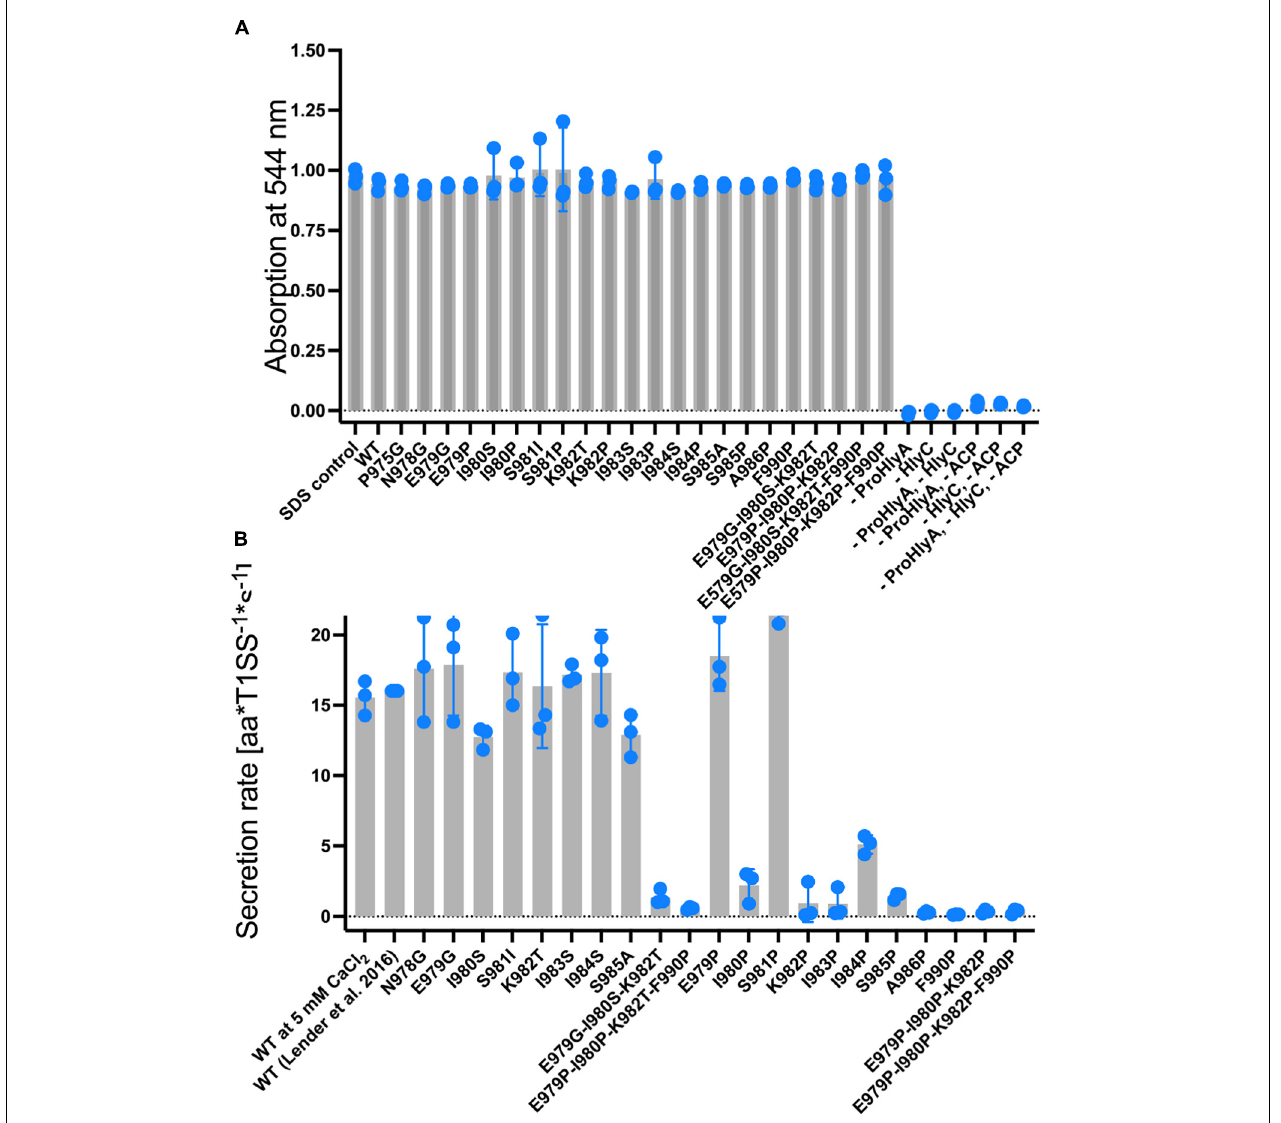
FIGURE 4 | (A) Normalized hemolytic activity of wild type HlyA (left bar), single, triple and quadruple mutations within the secretion signal. The lysis of erythrocytes was quantified by measuring the release of hemoglobin by absorption spectroscopy at 544 nm. Control measurements shown to the right of the quadruple mutations lacked HlyA (acylated form), the acylase HlyC, Acyl-carrier protein (ACP), or a combination of these, in the assay. These results demonstrated that lysis was only induced in the presence of acylated HlyA. HlyA is as efficient in hemoglobin release as an SDS incubation (Thomas et al., 2014b) (not shown). Individual assays were performed in at three biological independent experiments and shown as scatter dot plots. (B) Summary of the secretion rates of wild type pro-HlyA (left), single, triple and quadruple mutations within the putative secretion signal. The value “WT” was taken from Lenders et al. (2016). Data represent the average of three biologically independent experiments and are shown as scatter dot